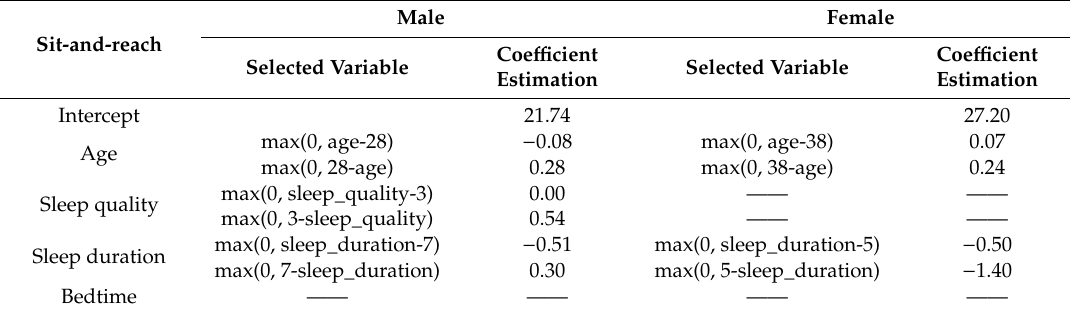
Table 6. Estimation results for sit-and-reach by gender.